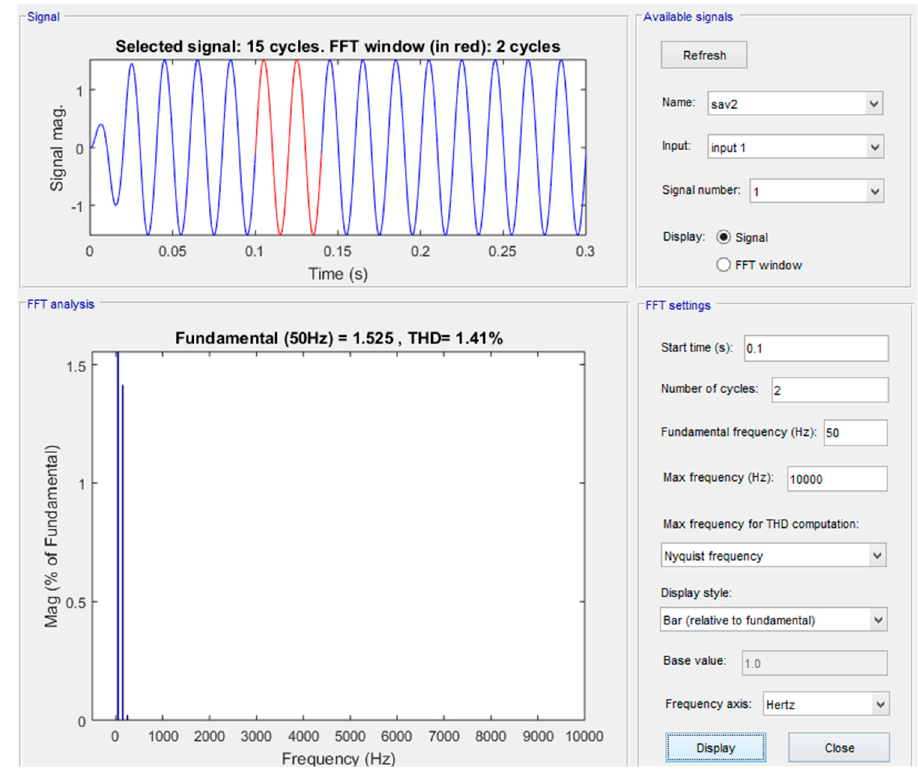
Figure 17. FFT analysis of output current. Table 5. Tracking time performance comparison [44]. P&O, perturb and observe; INC, incremental